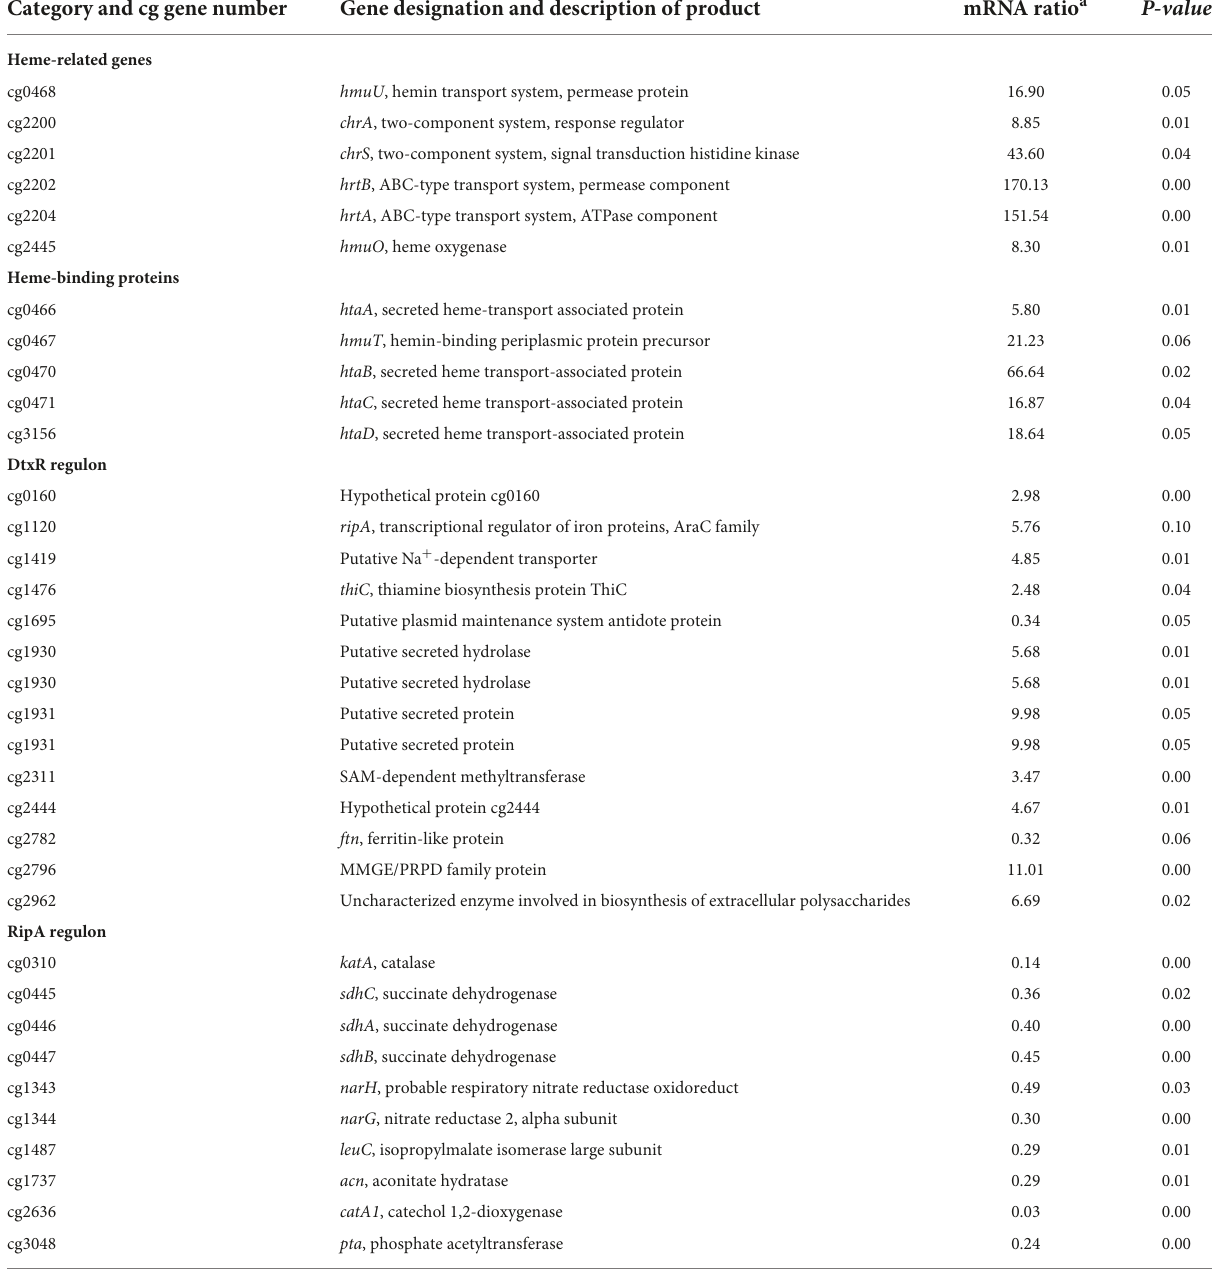
TABLE 2 Comparative transcriptome analysis of C. glutamicum wild type and C. glutamicum chrS -Ala245fs growing on 4 µ M heme. Category and cg gene